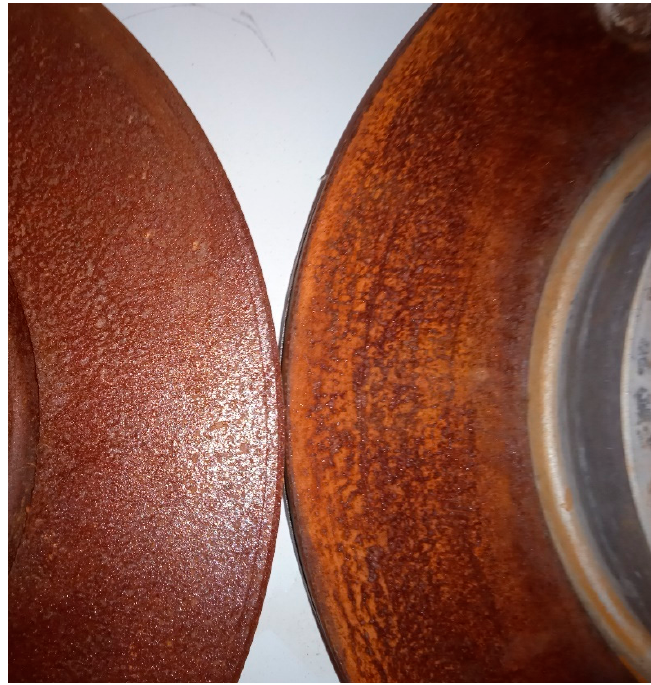
Figure 20. The low-priced brake disc is on the left and the mid-priced brake disc is on the right.